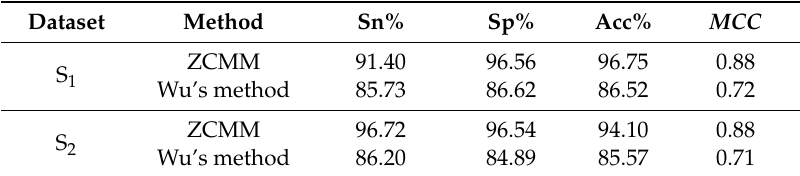
Table 4. ZCMM compared with Wu’s method in two datasets of S.